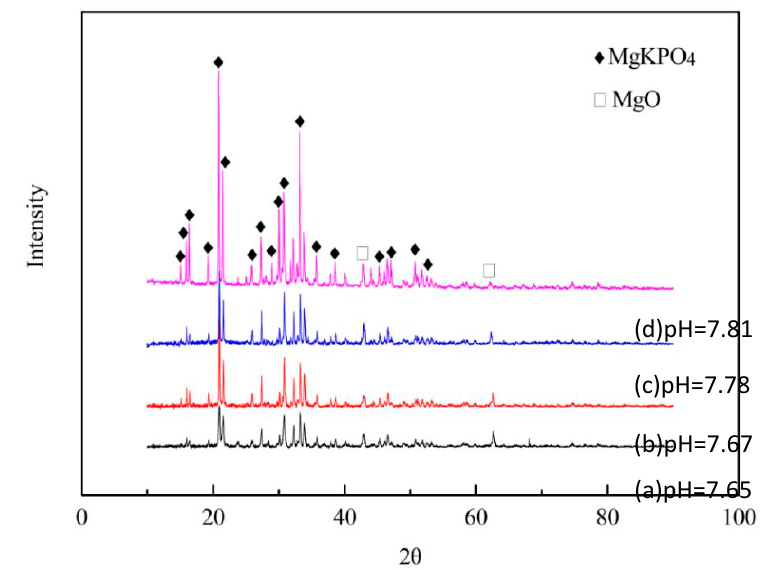
Figure 1. The hydration products and pH of MPC specimens. (a) 1:2; (b) 1:3; (c) 1:4; (d) 1:5.